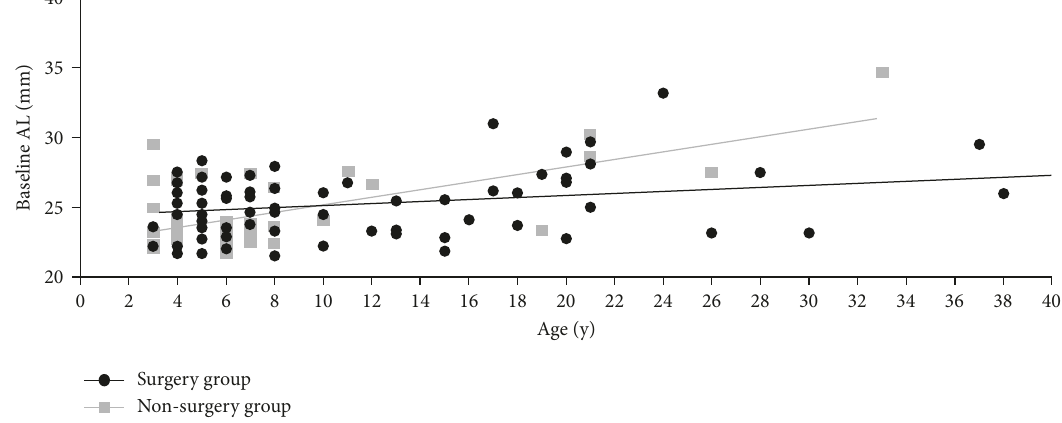
Figure 1: Distribution of axial length with age in the surgery group and the nonsurgery group of CEL patients.